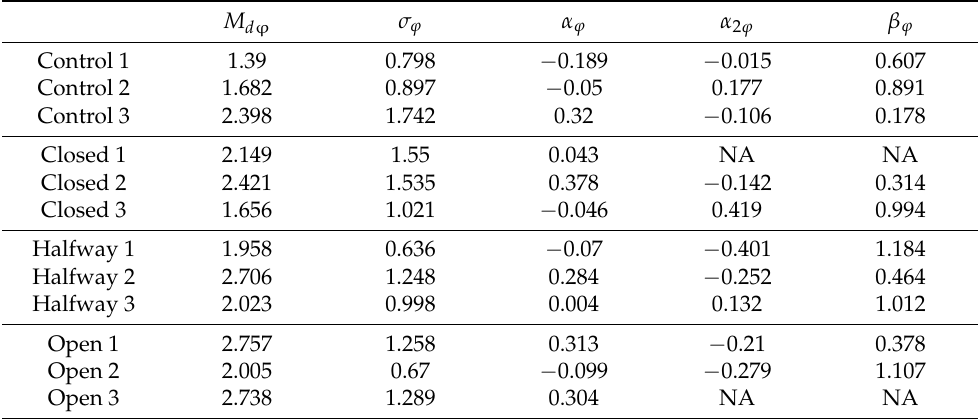
Table 4. Estimated parameters for the no shroud test.